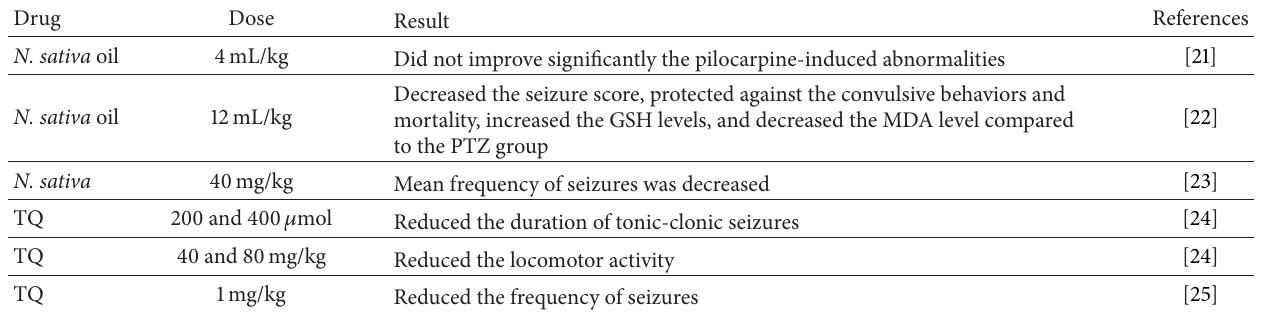
Table 3: The effect of Nigella sativa and TQ on